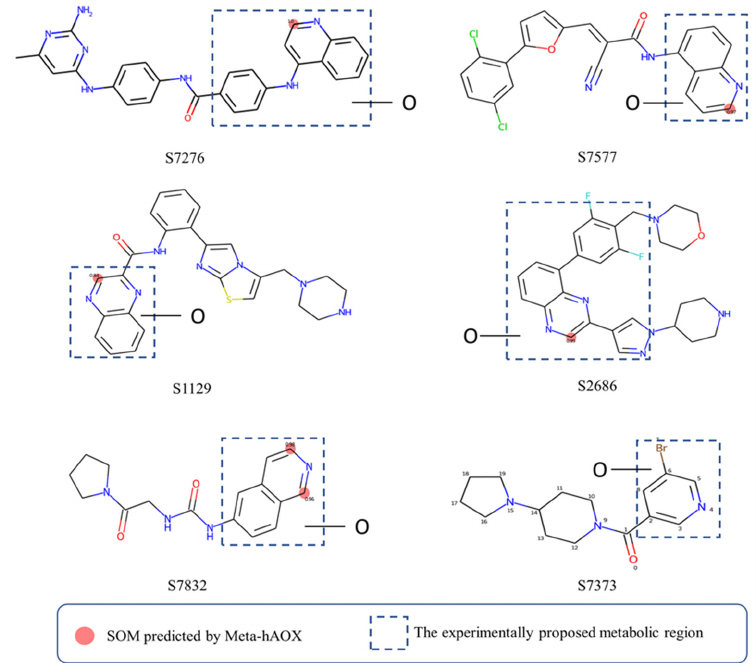
Figure 7. Case study of our